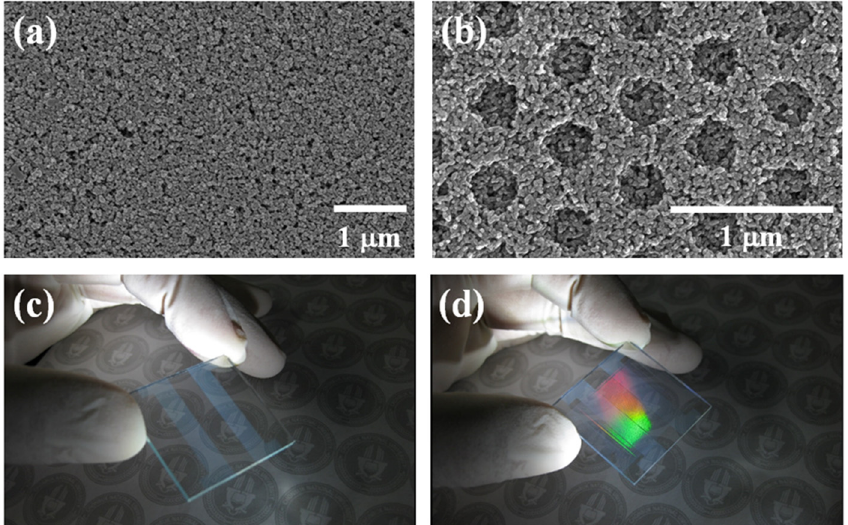
Figure 3. Images of nanopatterned mp-TiO 2 thin-film layer. ( a ) Non-nanopatterned mp-TiO 2 thin- film layer, and ( b ) nanopatterned mp-TiO 2 thin-film layer using FE-SEM. ( c ) Non-nanopatterned mp-TiO 2 thin-film layer, and ( d ) nanopatterned mp-TiO 2 thin-film layer using optical imaging.